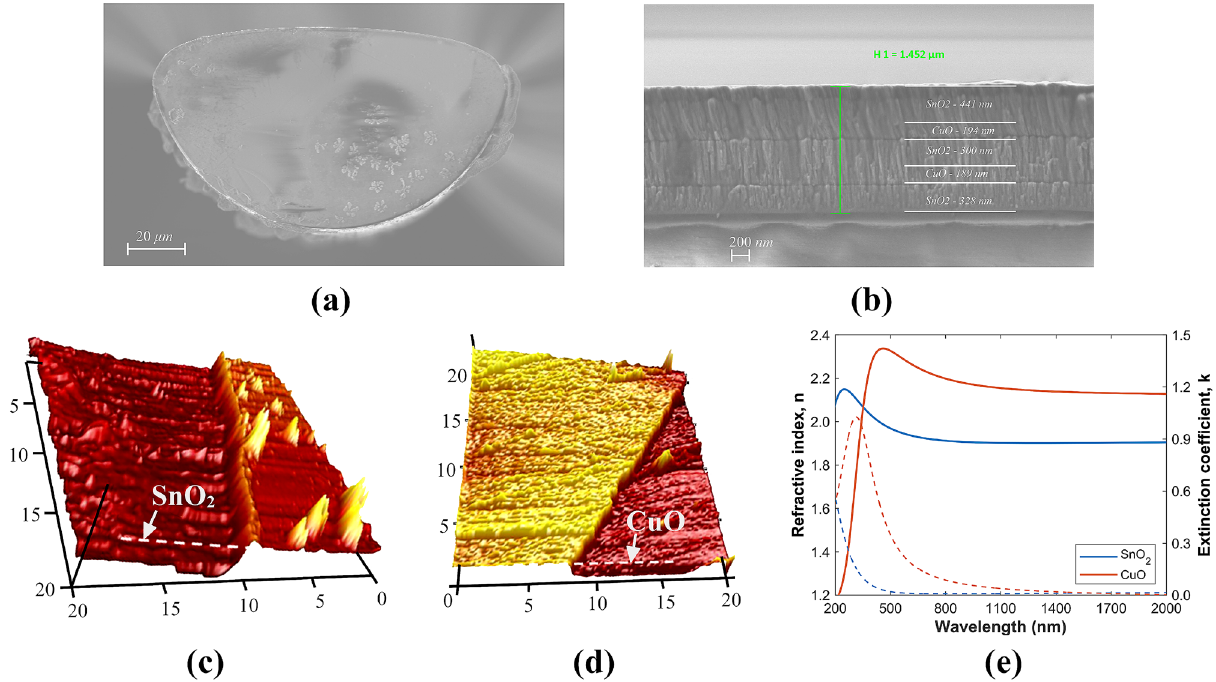
Figure 3. Characterization of coated D-shaped fiber with alternating layers of SnO 2 and CuO using a DC sputtering system. SEM images of the ( a ) D-shaped fiber cross-section with 5-layer 1DPC; ( b ) detail of the deposited 5-layer SnO 2 /CuO 1DPC. AFM microscope images showing the roughness of the thin films deposited on coverslips for ( c ) SnO 2 and ( d ) CuO, of 75 nm and 36 nm thickness, respectively. ( e ) Refractive index (solid lines) and extinction coefficient (dashed lines) of the SnO 2 (blue) and CuO (red) thin films. ( c - e ) adapted with permission form Ref. 45